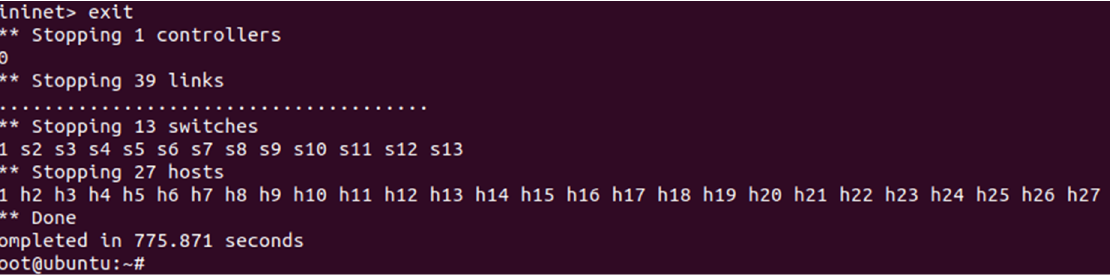
Figure 26. Model is oxm ‐ container on yang ‐ visualizer on DLUX console.